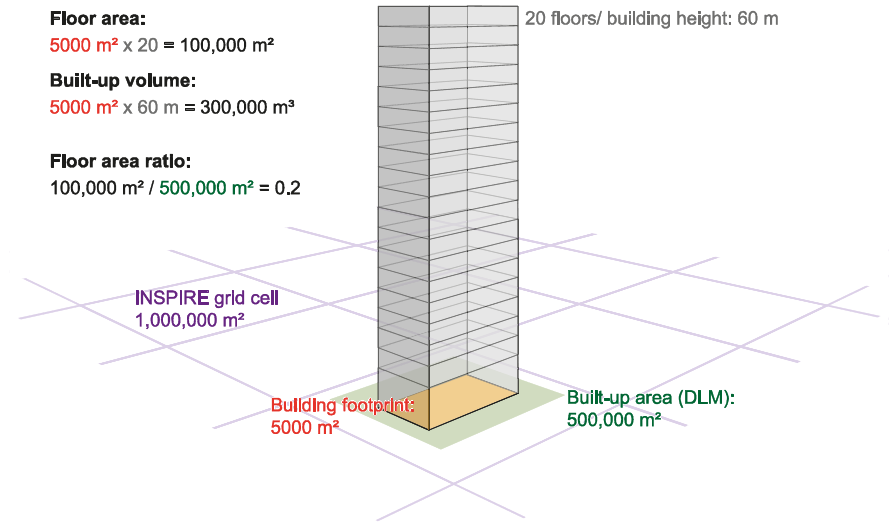
Figure 5. Calculation of built-up volume and FAR per INSPIRE grid cell.